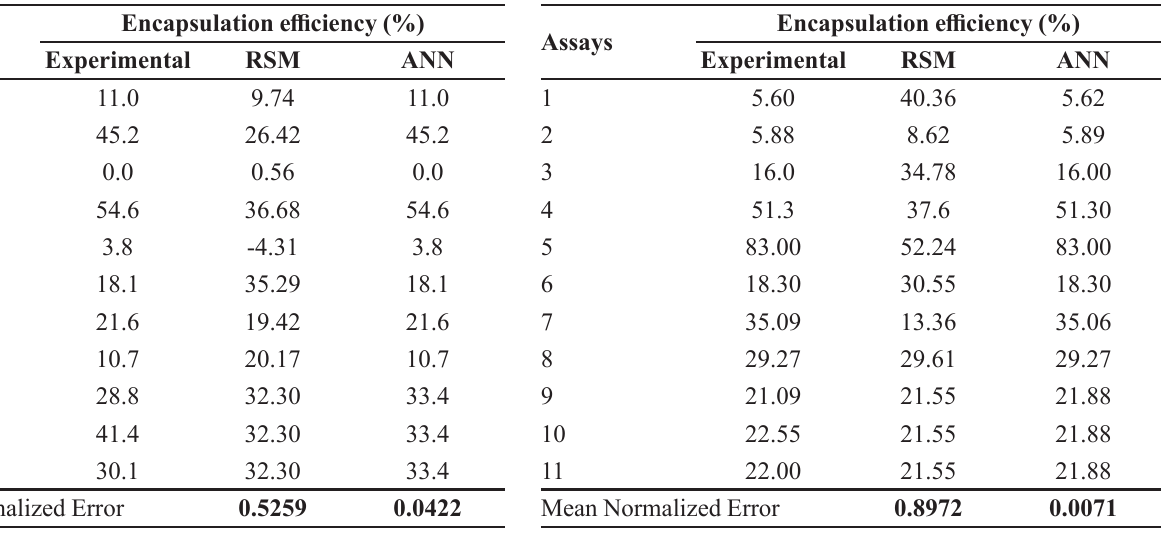
TABLE VII - Comparison between experimental data and predictive models generated by RSM and ANN. Data associated with Equation 7